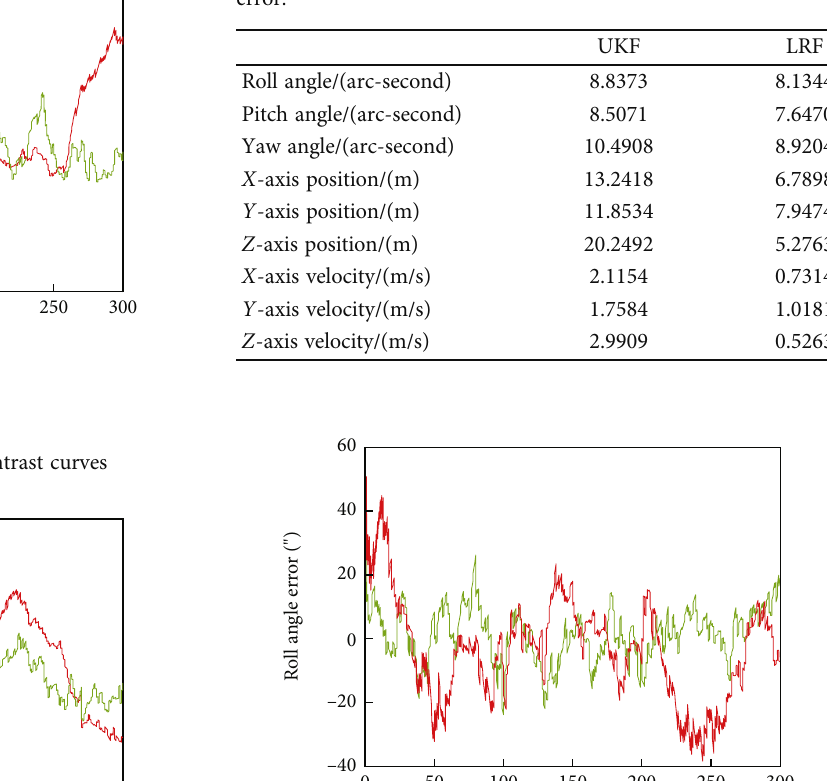
Table 3: Root mean square of navigation parameter estimation error.